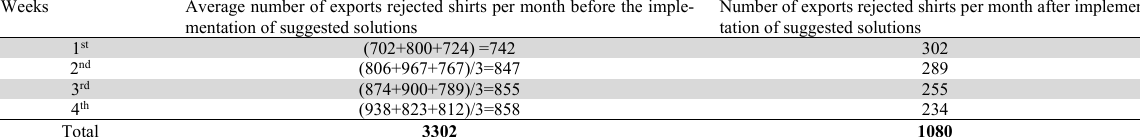
Total number of exports rejected shirts after implementation of suggested solutions 7 Weeks Average number of exports rejected shirts per month before the imple- mentation of suggested solutions